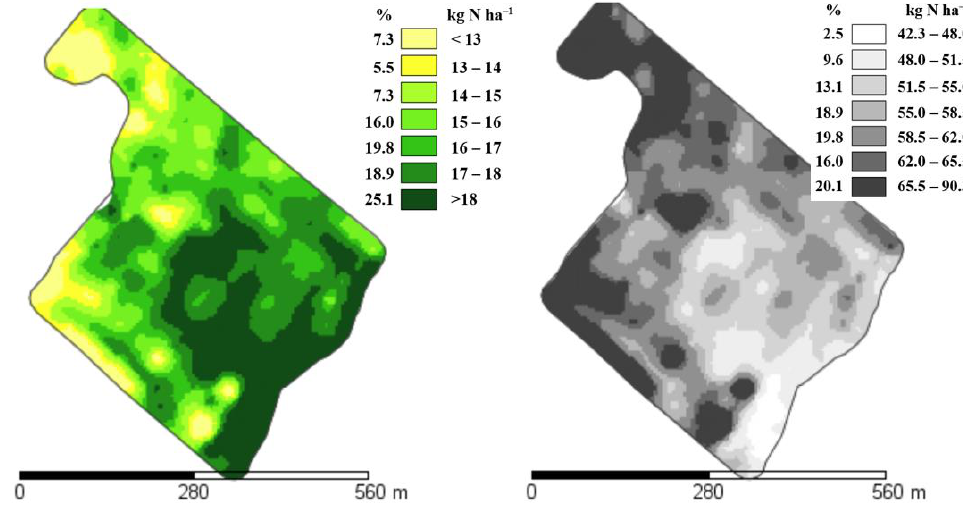
Figure 2. Maps of nitrogen uptake by crops ( left ) and variable-rate fertilization ( right ).